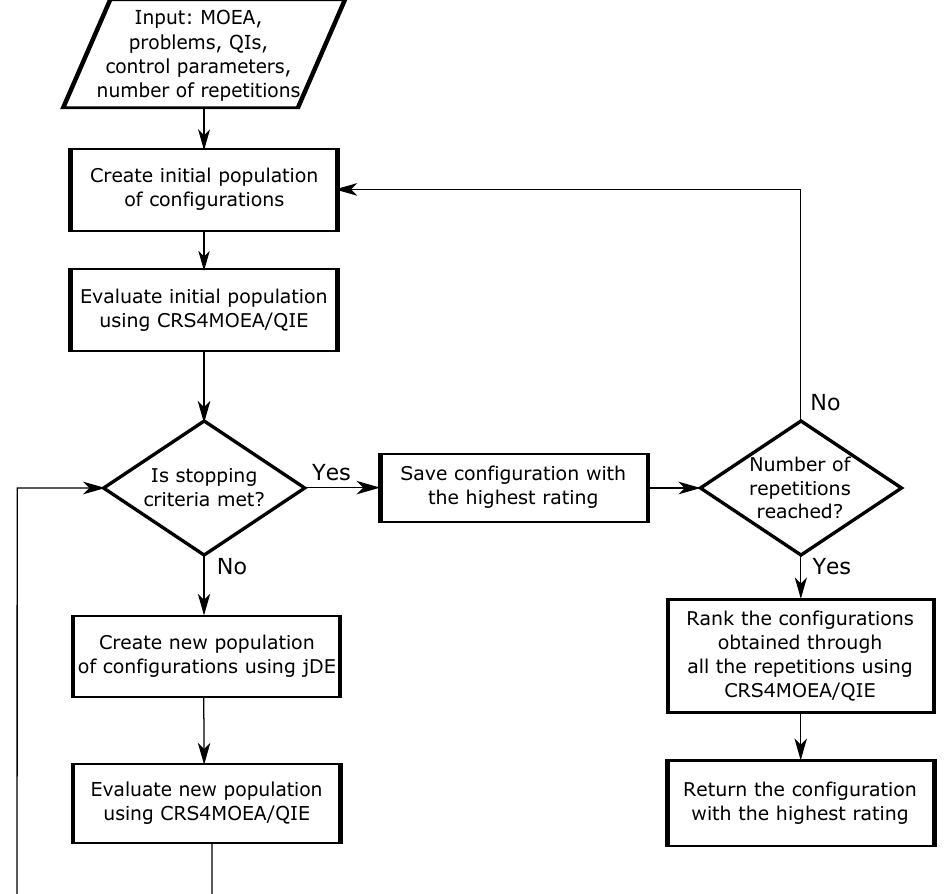
Figure 2. MOCRS-Tuning